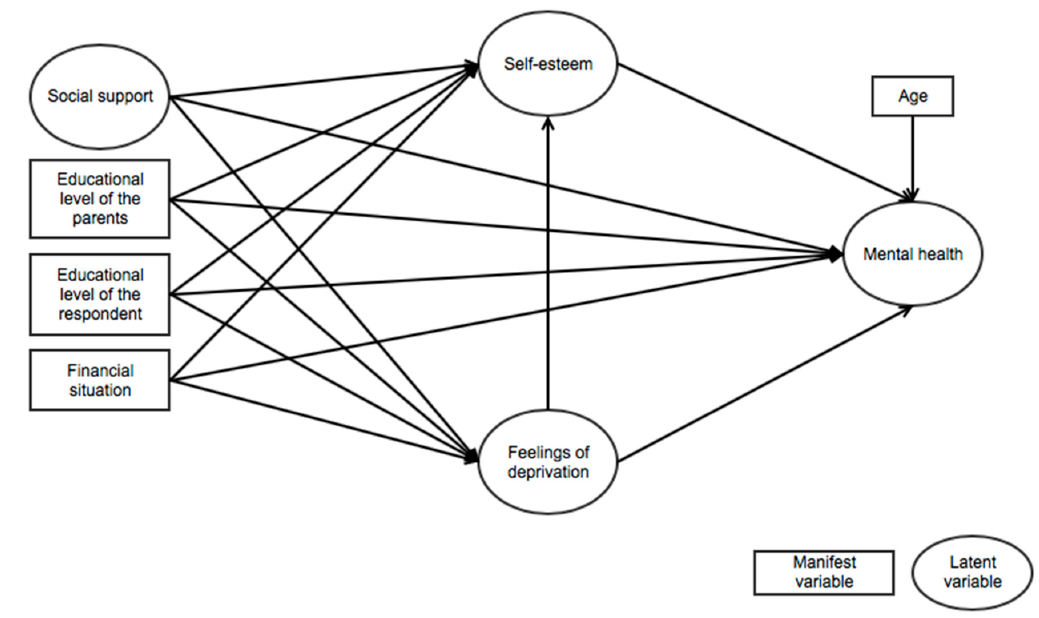
Figure 1. Final Structural Equation Model.